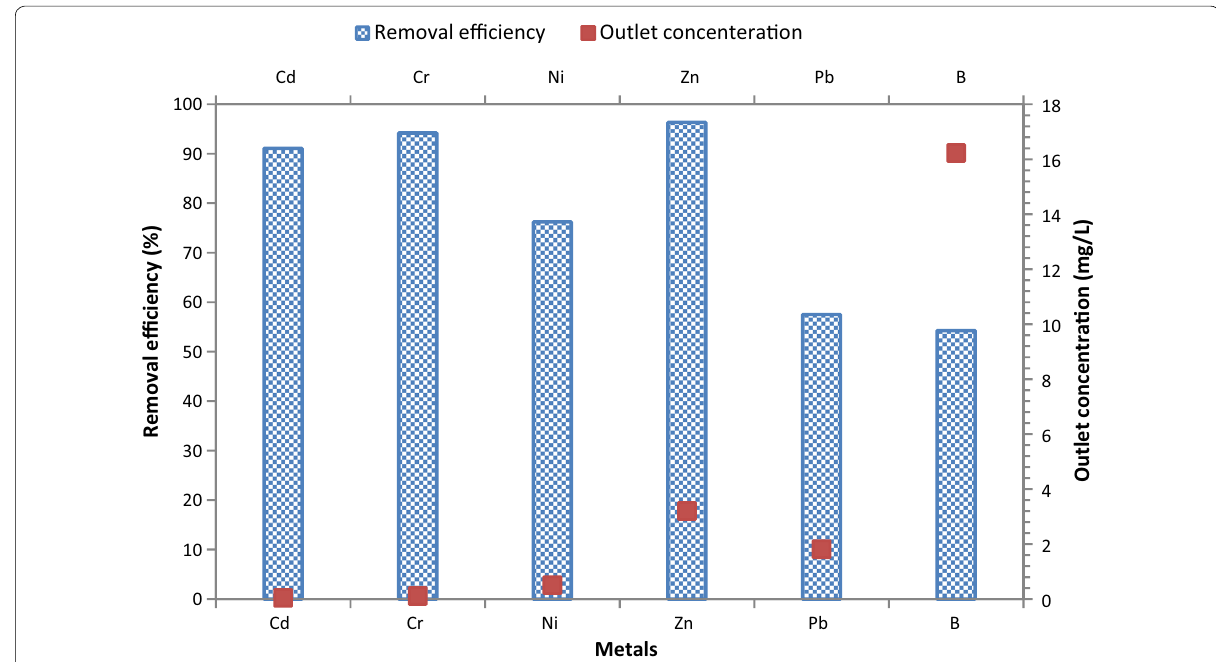
Fig. 8 Removal efficiency and outlet concentration of heavy metal and born in the coagulation–flocculation process (at pH PAC 300 mg/L, anionic nonionic polymers = +